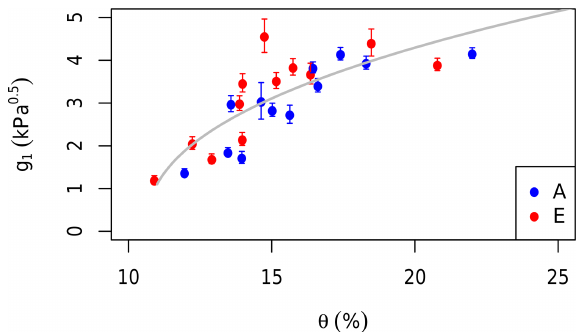
Figure 3. The impact of the soil moisture content ( θ ) in the top 150cm on stomatal regulation. The g 1 parameter values are fitted to measurements of leaf gas exchange grouped by month and treat- ment. Red dots are fitted to data from elevated rings while blue are ambient rings. Error bars indicate the standard errors of the fitted values. The grey line shows the fit of Eq. (2) to the